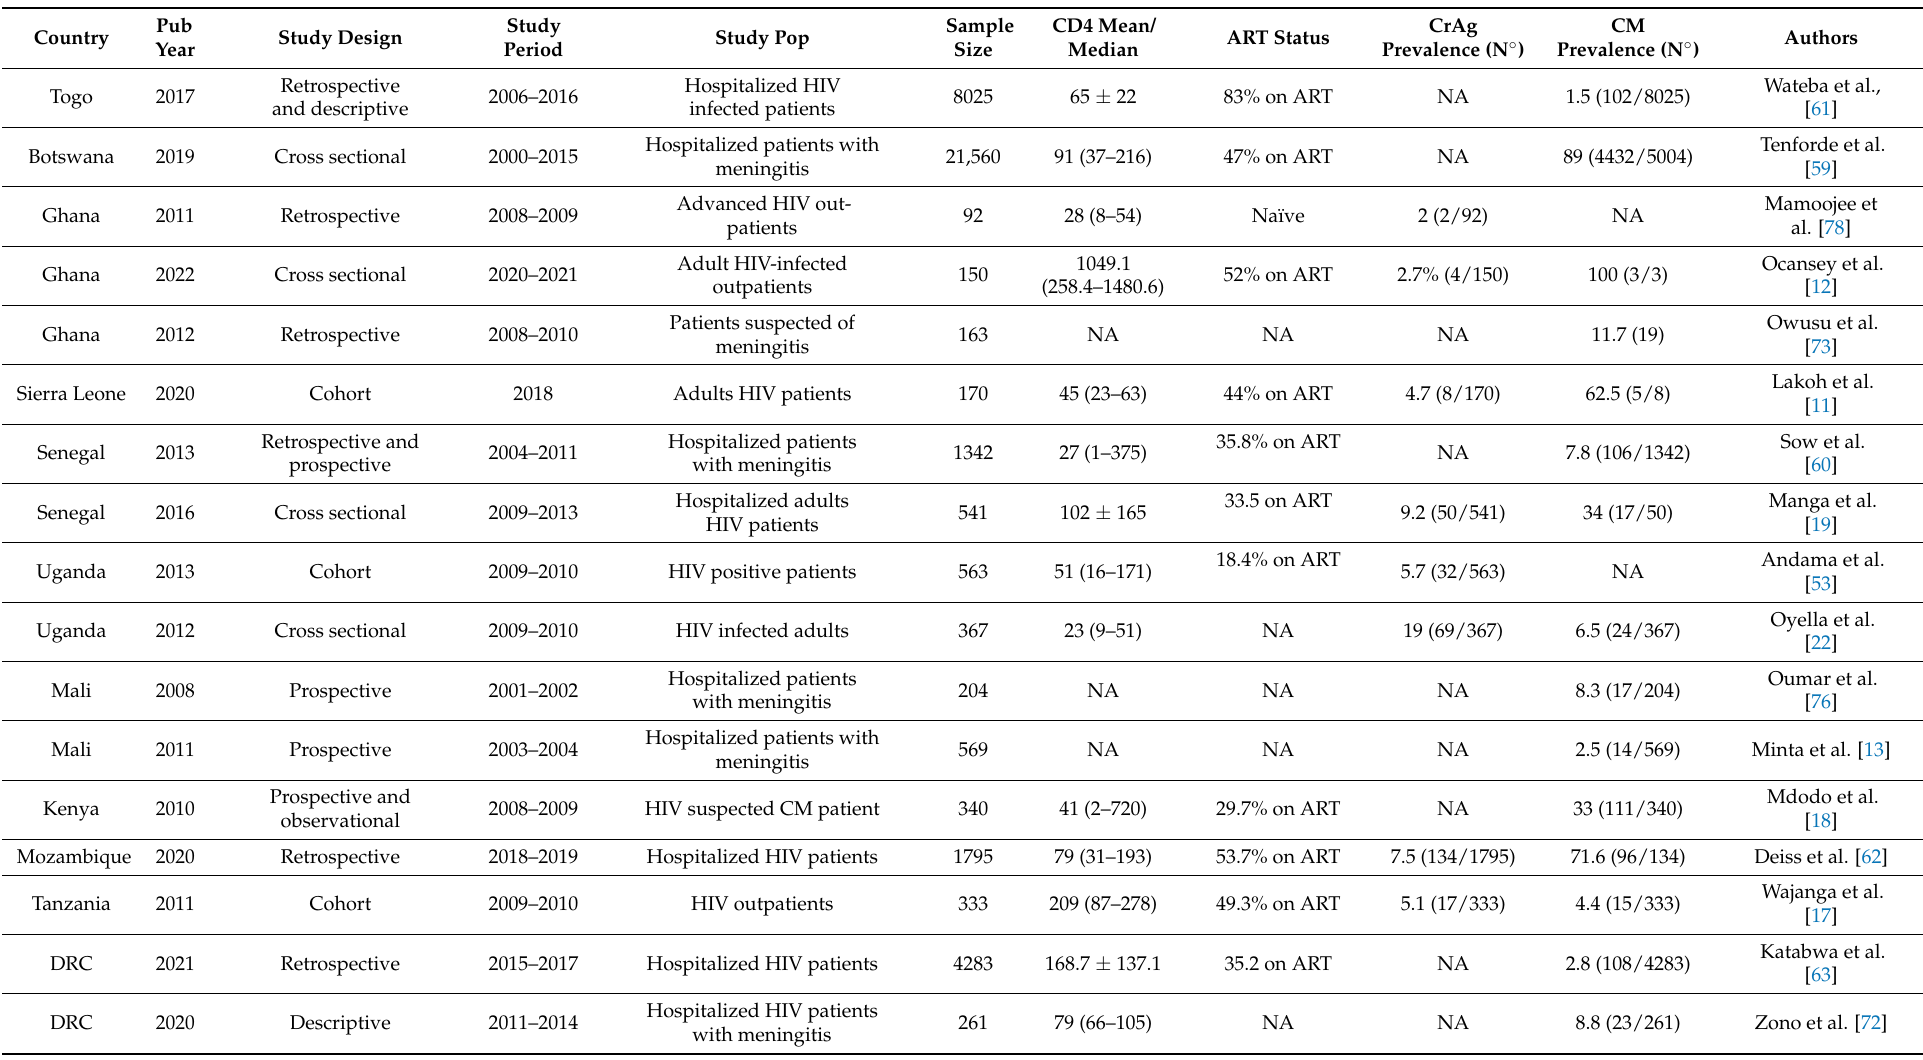
Table 2. Prevalence of cryptococcal disease across